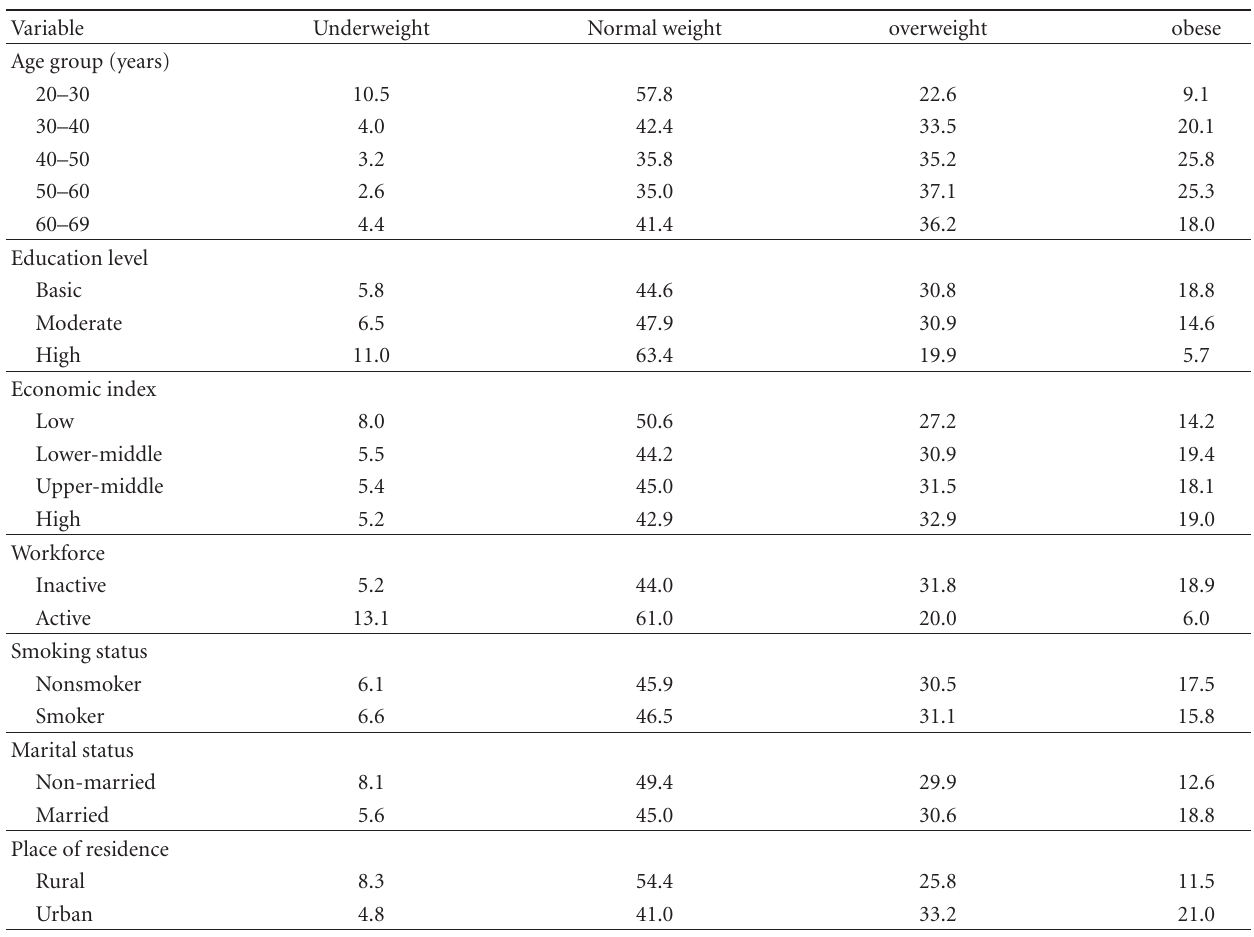
Table 1: Prevalence (%) of underweight, normal weight, overweight, and obesity according to sociodemographic and smoking in a random sample of 14176 women in Iran,